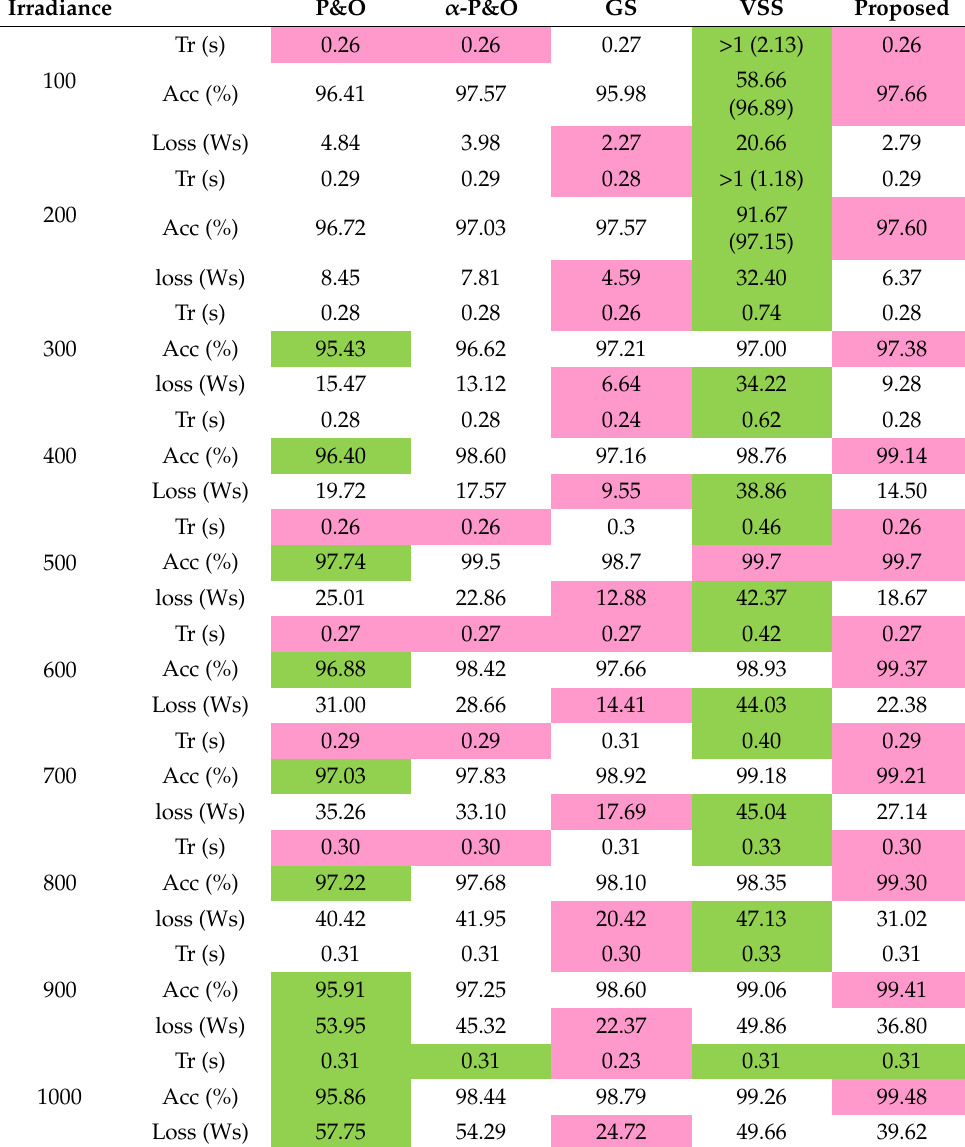
Table 6. Experimental results of five compared MPPT methods under uniform insolation condition.